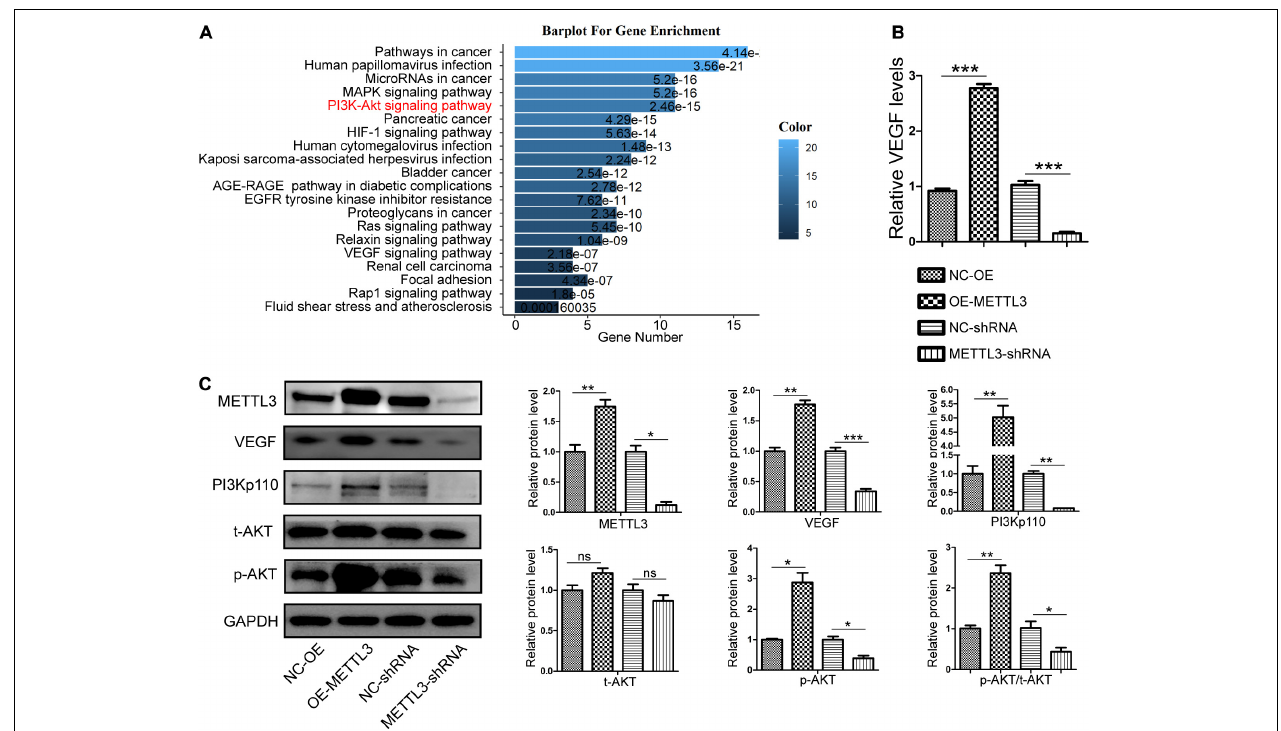
FIGURE 3 | Methyltransferase-like 3 enhances PI3K/AKT signaling pathway activation and angiogenic cytokine production. (A) Gene Ontology enrichment analysis of the angiogenic targets of METTL3. (B) Following METTL3 knockdown or overexpression, the mRNA levels of the angiogenic cytokine VEGF were significantly altered. (C) PI3K/AKT signaling pathway and angiogenesis-related proteins including PI3Kp110, AKT, p-AKT, and VEGF were assessed via Western blotting in EPCs, with ImageJ being used for analysis. Analyses were conducted using data from three independent experiments. NC-OE and OE-METTL3 groups or NC-shRNA and METTL3-shRNA groups were compared via Student’s t -tests. ns P > 0.05, * P < 0.05, ** P < 0.01, *** P < 0.001; n = 3 in each independent experiments.